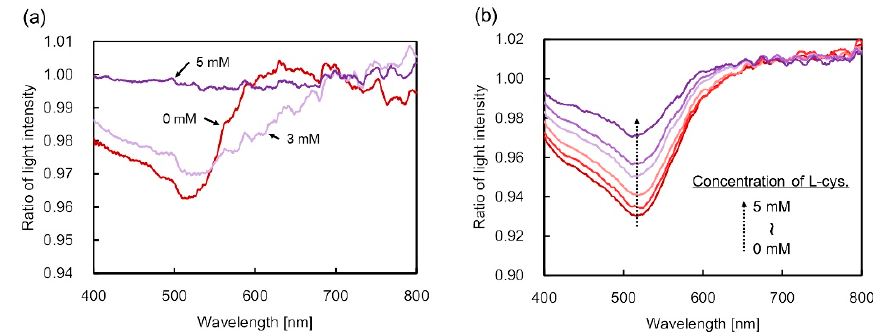
Figure 3. Optical extinction spectra acquired with the picoliter cuvette inside an optical fiber for changes in L-cysteine concentration. ( a ) and ( b ) are for gold mass concentration cases of 2 wt% and 4 wt%, respectively. The numerical value in the graph represents the concentration of L-cysteine.